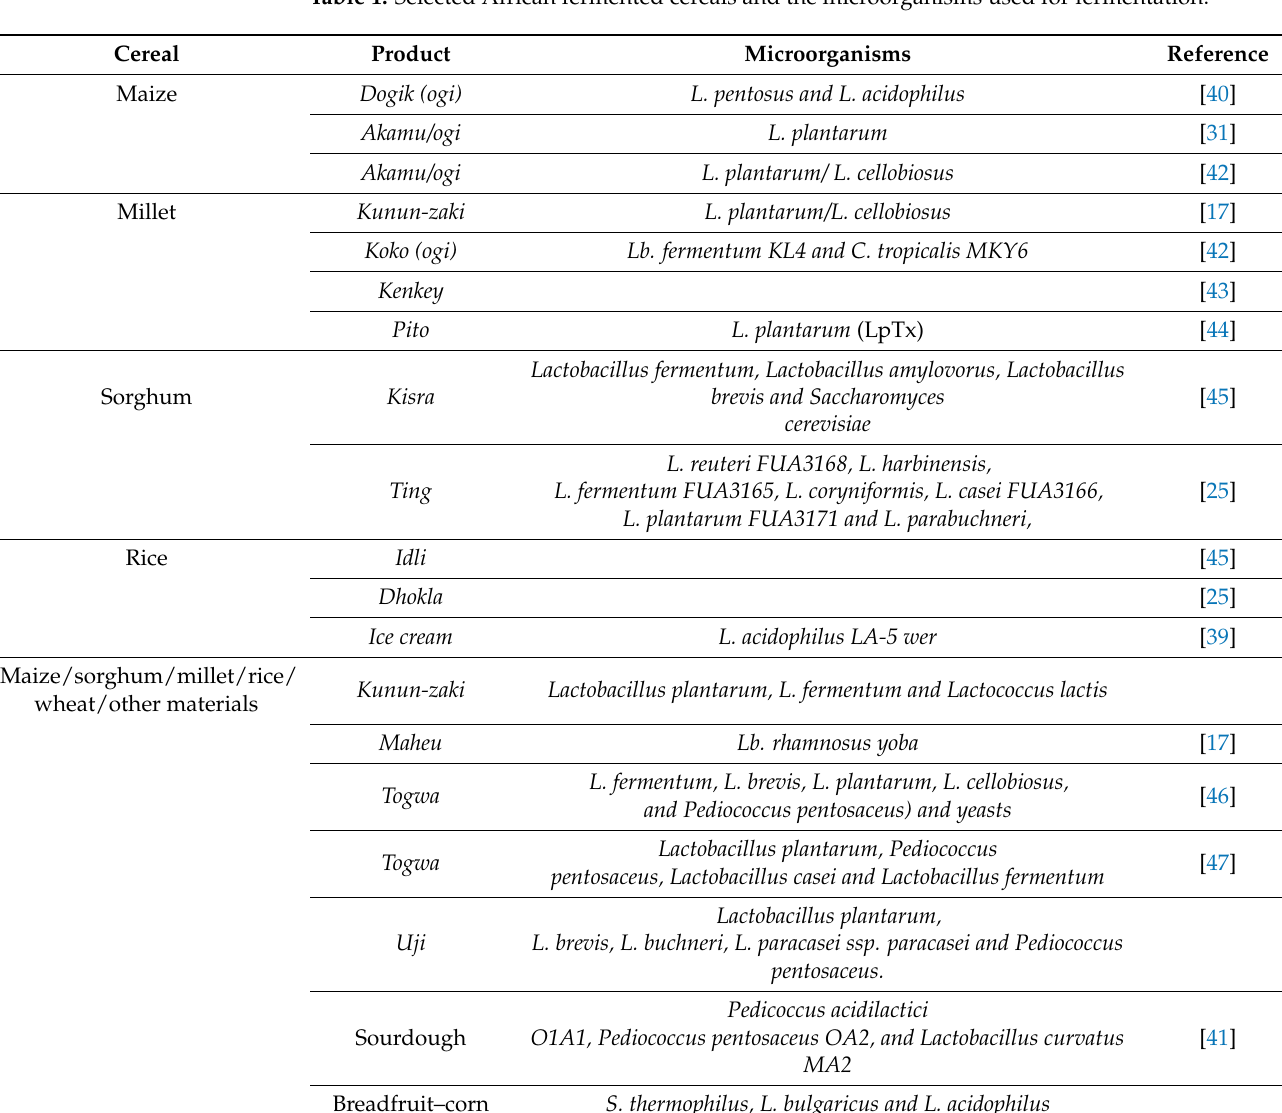
Table 1. Selected African fermented cereals and the microorganisms used for